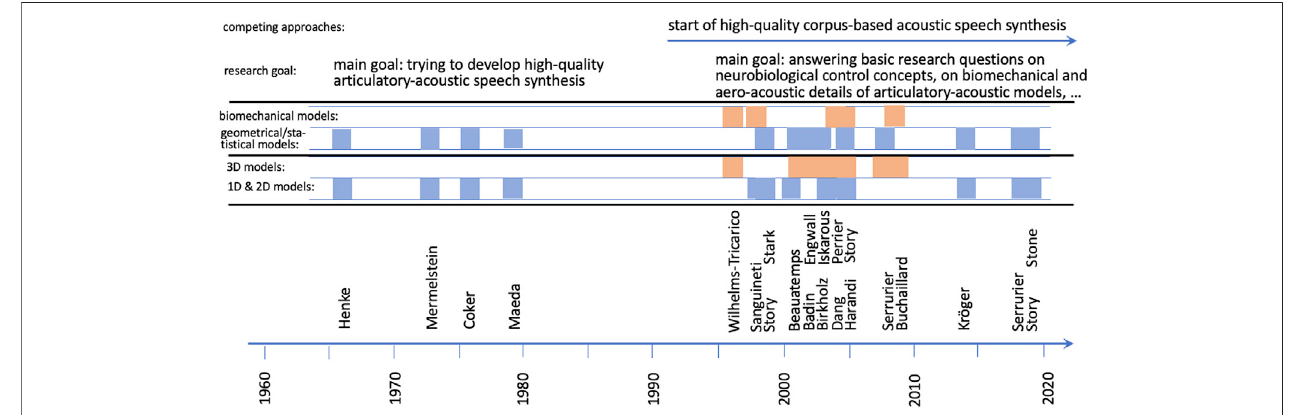
FIGURE2| Visualizationoftheevolutionofarticulatorymodelsovertime.Modelsarecitedherebythe fi rstauthor,aslistedin Table1 .Mainresearchgoalsandtwo criteria for differentiating articulatory models (biomechanical vs. geometrical and statistical models; 1D and 2D models vs. 3D models) are labeled and visualized.